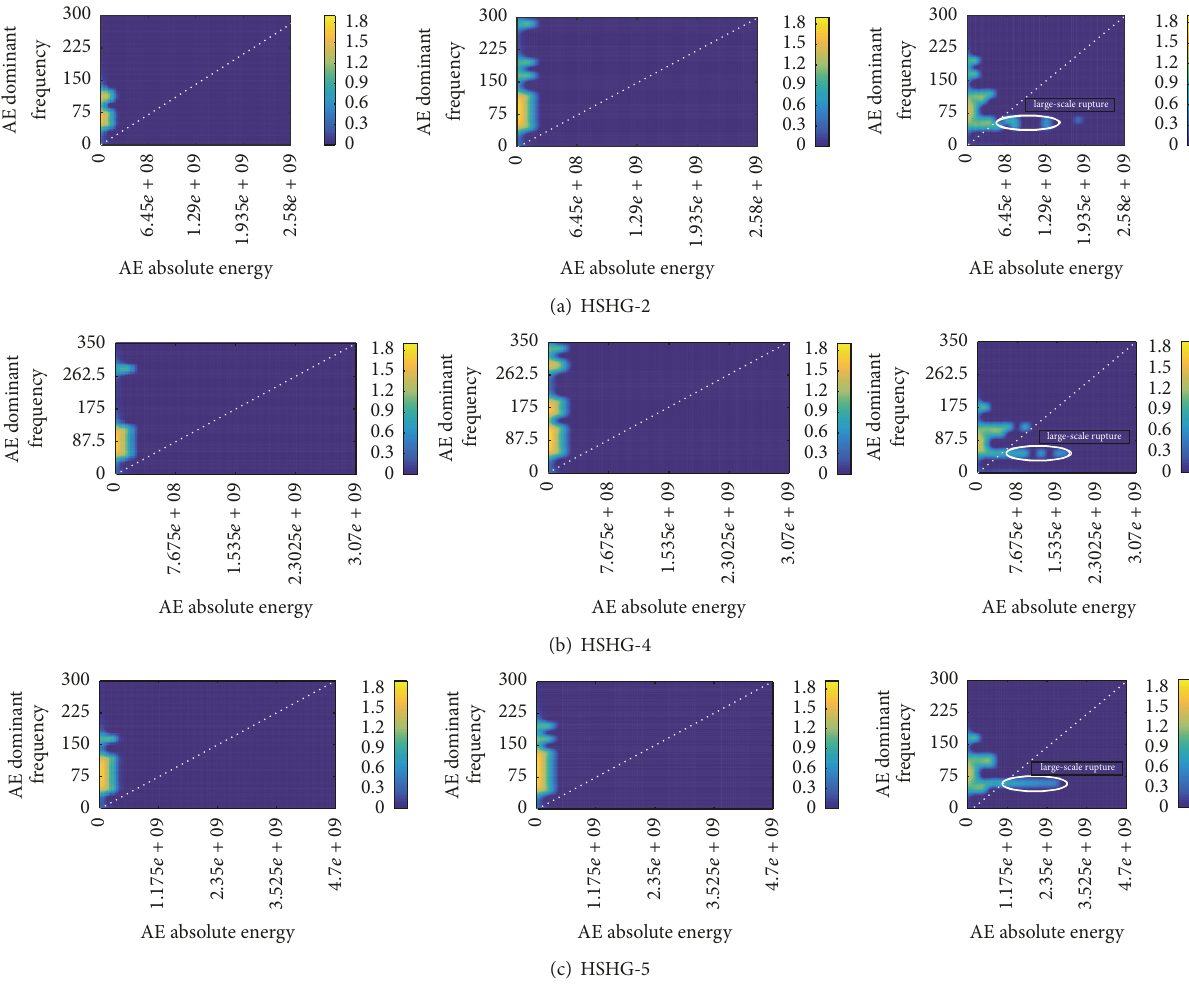
Figure 10: Acoustic emission energy-frequency distribution of granite during